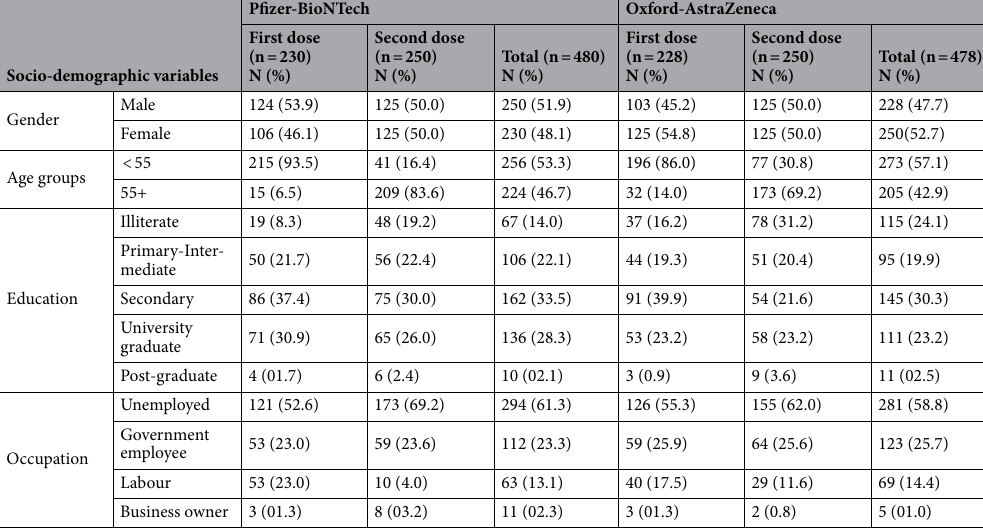
Table 1. Sociodemographic variables of the included vaccinated individuals.